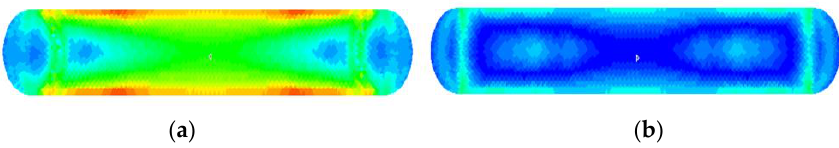
Figure 17. Residual magnetization distribution according to protocols using simulation. ( a ) Conven- tional Flash-D ( b ) Proposed protocol.